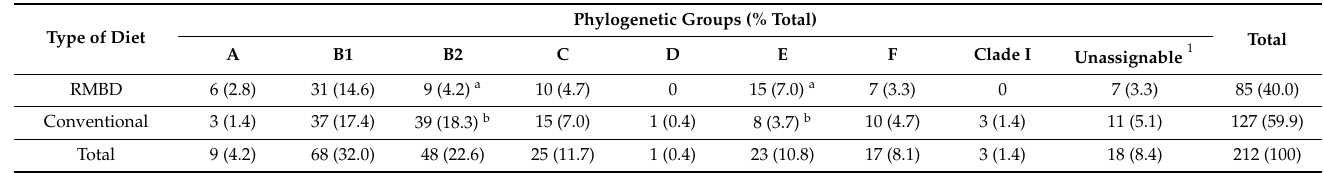
Table 1. Phylogroups of E. coli isolates from dogs fed with raw meat-based diets (RMBDs) and conventional dry feed. Different letters in a phylogroup column indicate statistical differences among dog groups fed with the different diets ( p ≤